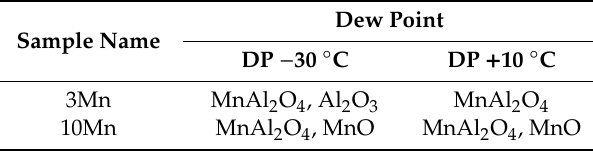
Table 2. Stable oxides under different dew points by calculation.